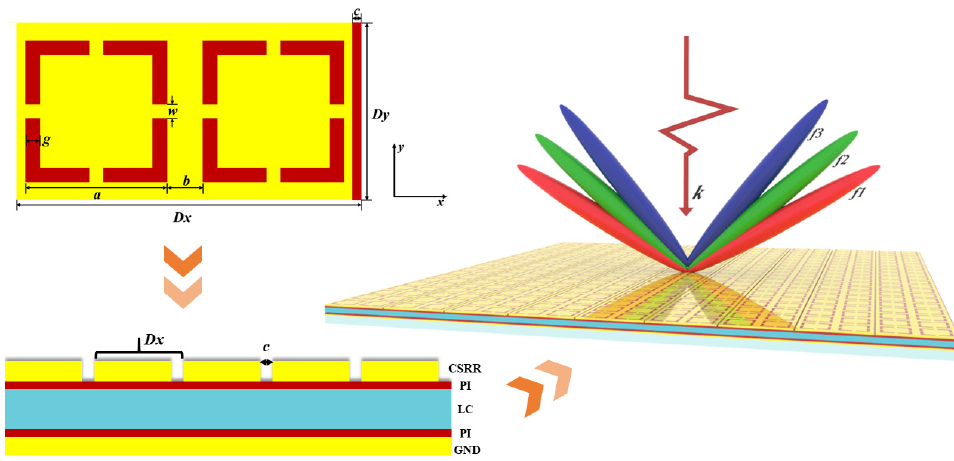
Figure 1. Schematic configuration of the metasurface grating. The geometric parameters of the unit cell are as follows: a = 160 µ m, b = 40 µ m, c = 6 µ m, g = 16 µ m, w = 16 µ m, D x = 400 µ m, and D y = 200 µ m. The metasurface consists of seven layers, which from top to bottom, are quartz, complementary split-ring resonator (CSRR), Polyimide (PI), liquid crystal (LC), PI, metal ground, and silicon sub- strate. The thickness of the metal layer (gold), PI, and LC are 300 nm, 90 nm, and 45 μ m, respectively. Silicon substrate and ultrathin quartz (which are not shown in the schematic) are used to support the metal ground and metallic CSRR, respectively, and PI layers engineered with parallel grooves are contributed to the pre-orientation of liquid crystal molecules.